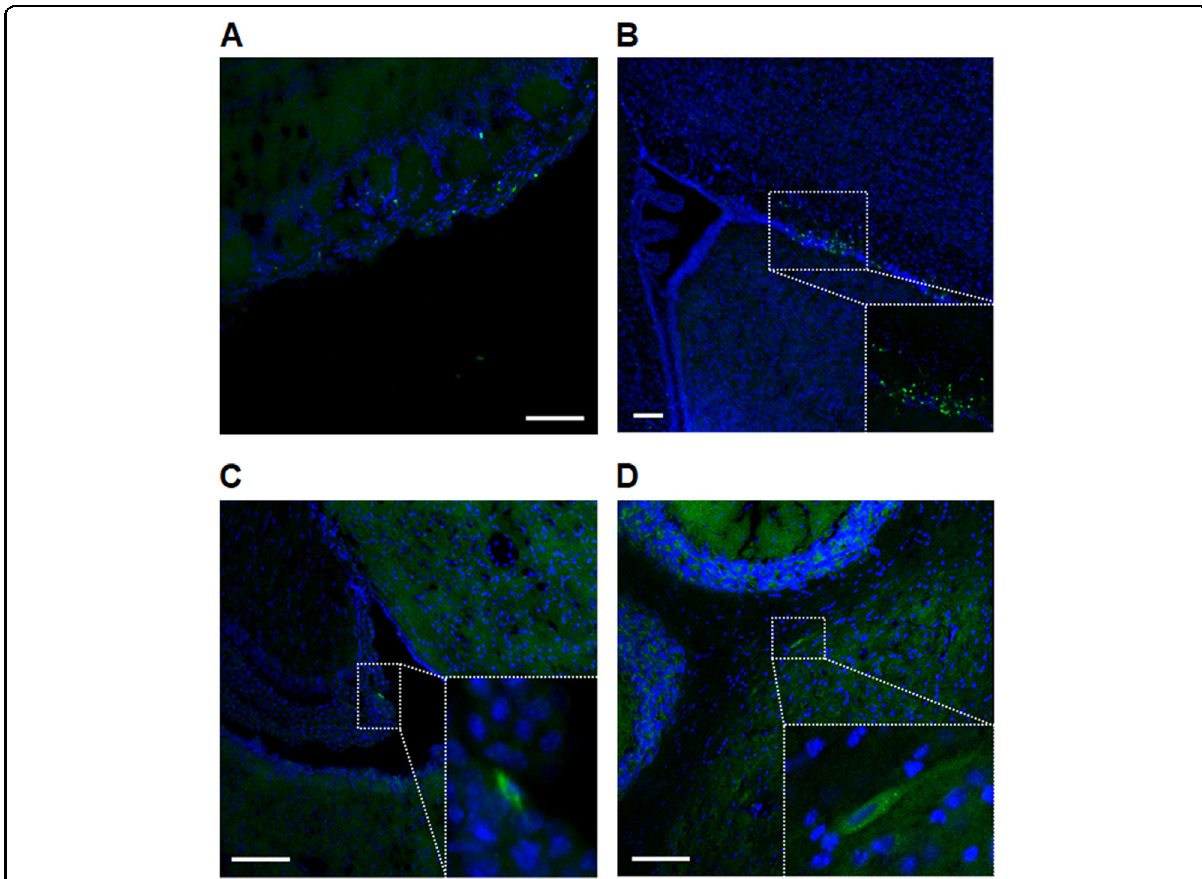
Fig. 1 hUCB-MSC location in the brain after intranasal administration. a Increased density of GFP-expressing hUCB-MSCs within the glomerular layer of the olfactory bulb. b A different distribution pattern, focused throughout the rostral migratory stream, was examined. c No dense GFP- expressing hUCB-MSC was exhibited in the hippocampus area; however, single cells that expressed GFP were visible and magni fi ed. d The deep cerebellar nuclei also show single hUCB-MAC-expressing GFP and were also magni fi ed. Scale bars = 50 μ